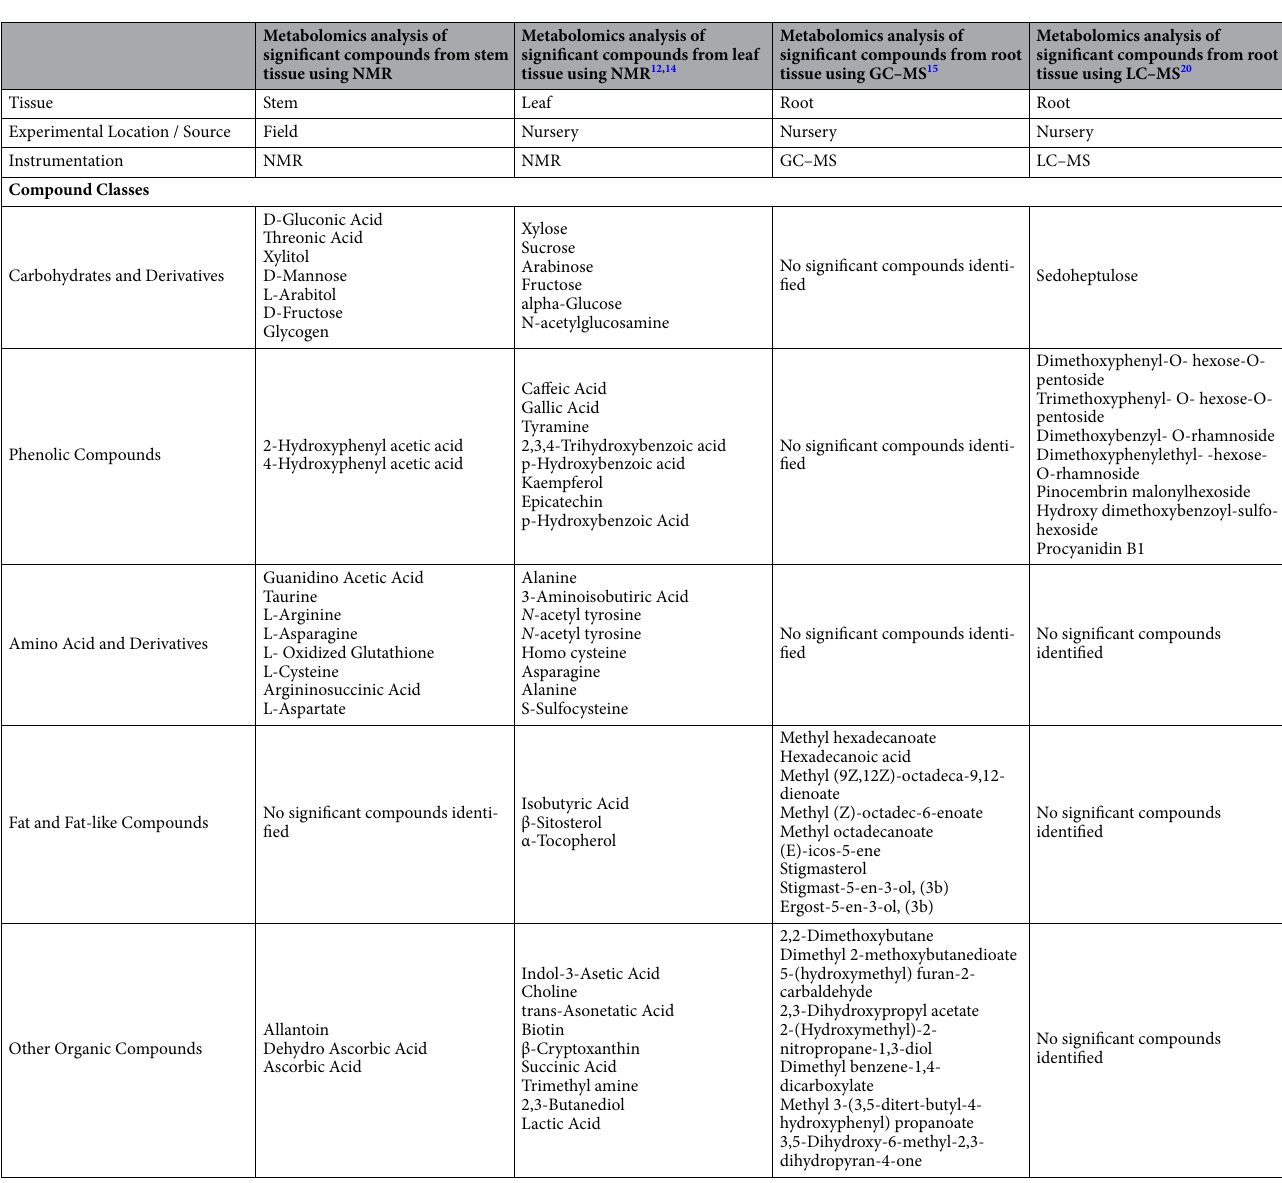
Table 4. Results of significantly identified compounds in stem tissue metabolomics studies with NMR and compilations with previous studies using GC–MS and